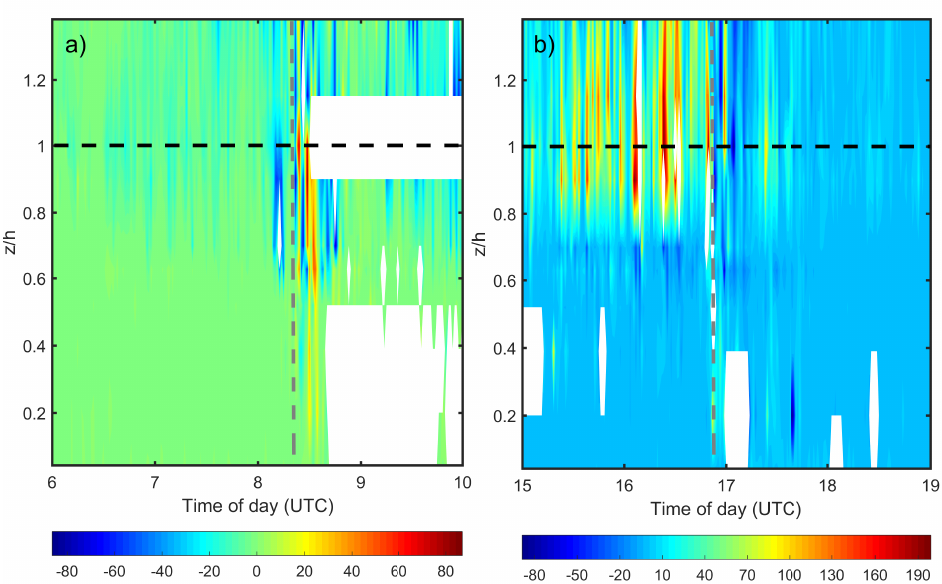
Figure 6. Temporal variation of the vertical profile of the sensible heat flux, H, (W m − 2 ), on 21 April 2014, measured at site T0k, during the passage of branch 1 ( a ) and branch 2 ( b ) of the SL2. The dashed black line indicates the forest canopy-top height. The dashed gray line indicates the arrival time of the downdrafts near the top of the forest